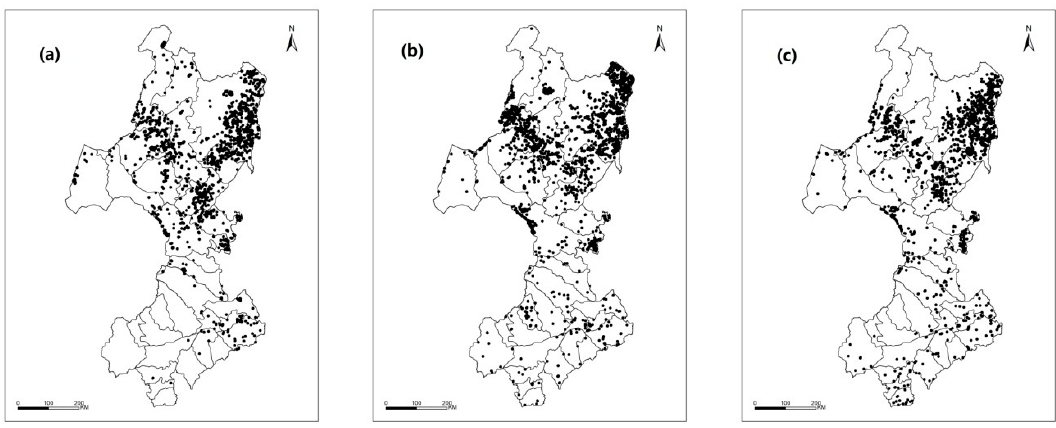
Figure 2. Active grassland fire events in the study area: ( a ) 2000–2002; ( b ) 2003–2007; ( c ) 2008–2012. Table 4. Number of active grassland fires in per administrative region.